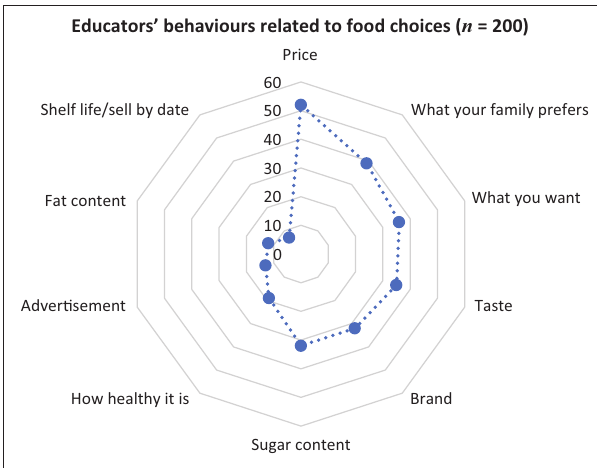
FIGURE 1: Sources of nutrition information.